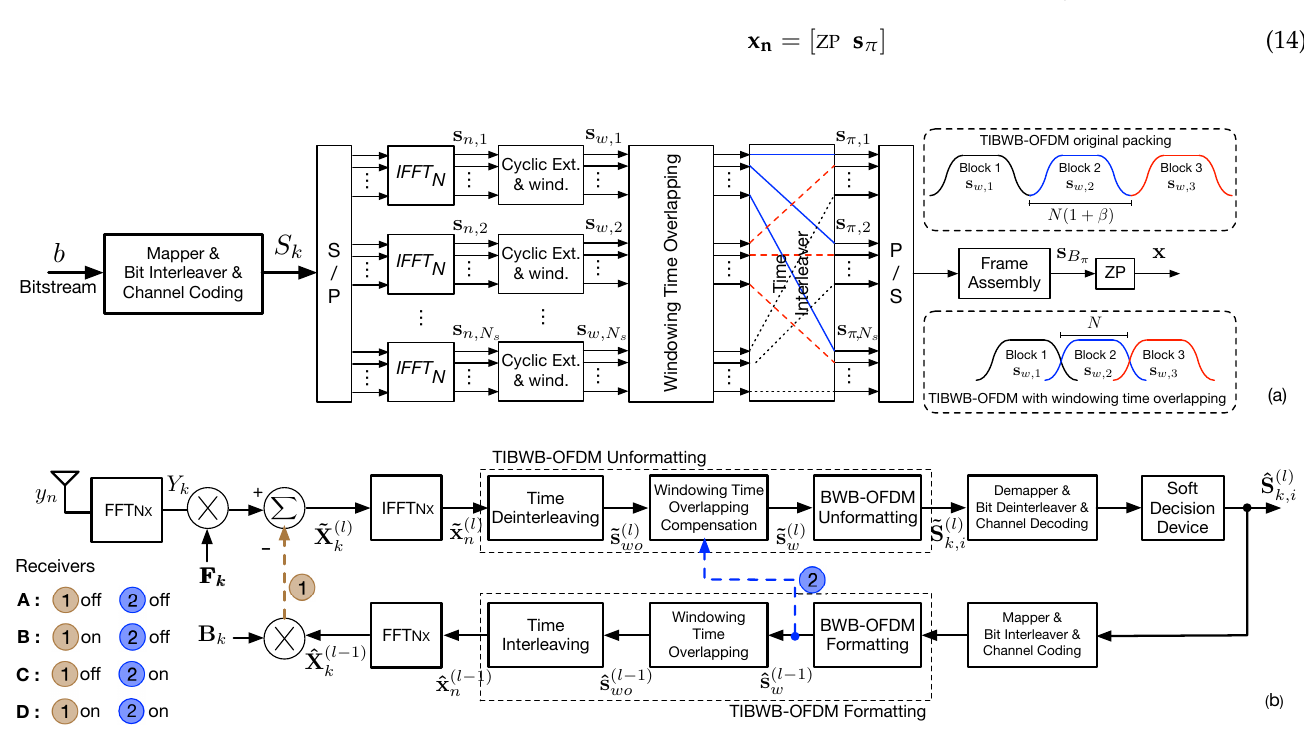
Figure 4. TIBWB-OFDM with WTO transmitter ( a ) and receiver ( b ). Conventional TIBWB-OFDM is obtained by removing the WTO block in transmitter and WTO compensation in receivers A and